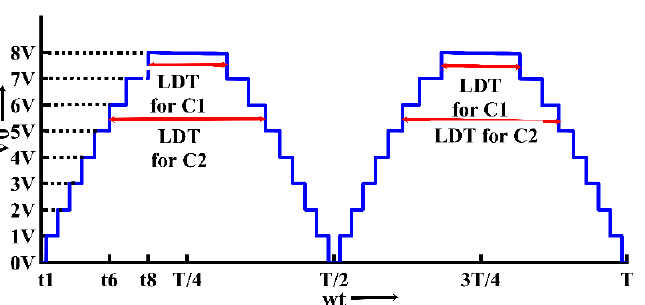
Figure 4. Waveform of output voltage (inverted negative half-cycle) along with the longest discharge time (LDT) of capacitors in asymmetric configuration.